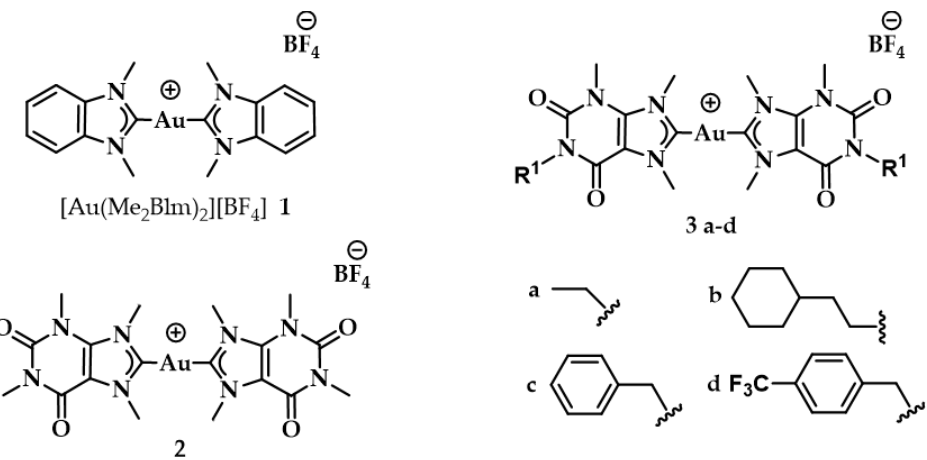
Figure 12. Chemical structures of Au(I) Benzimidazolylidene (Blm) and caffeine-based NHC com-